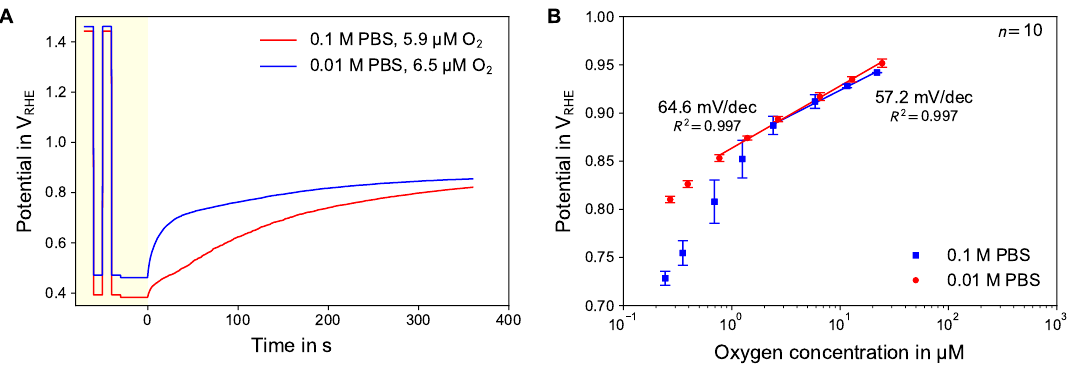
Figure 5. Influence of the ion-strength of the electrolyte: Comparison of time trace ( A ) for concentration with same oxygen fraction in gas phase and calibration curves ( B ) using a duration of 360s for the OCP